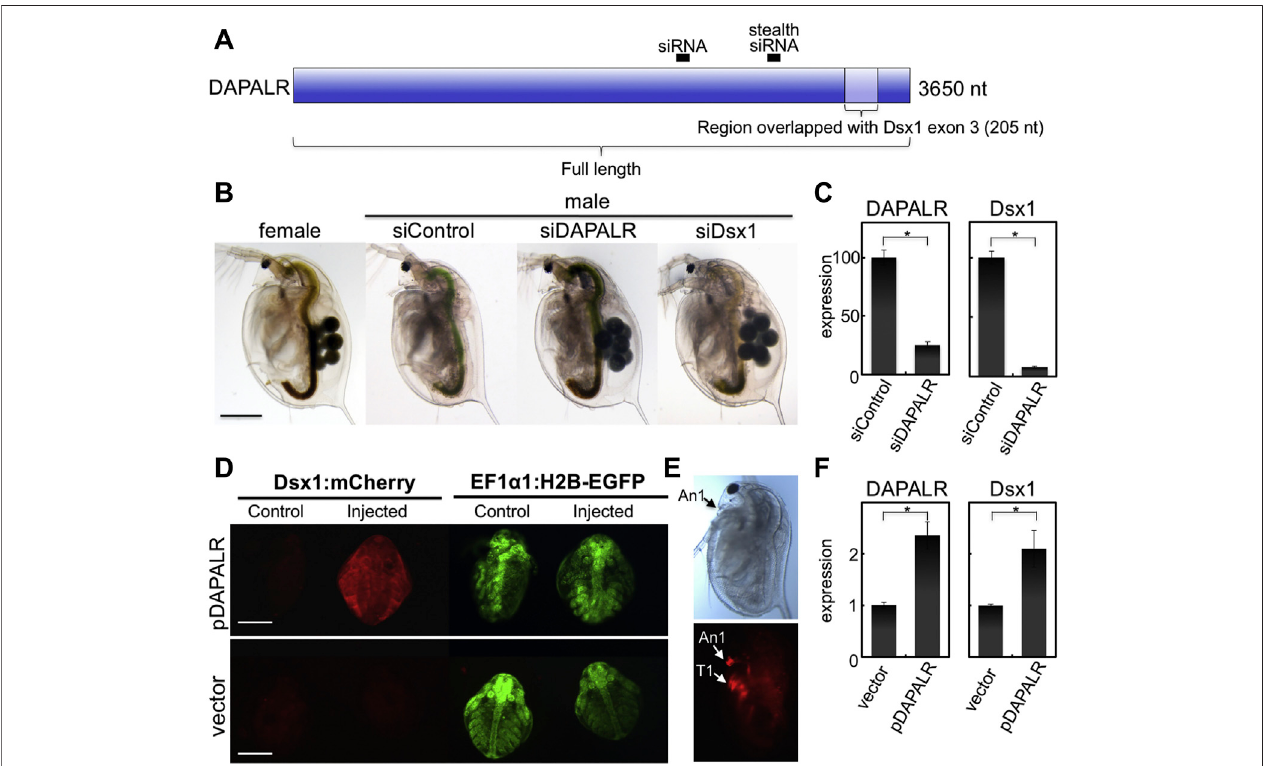
FIGURE12| Knockdown andoverexpressionof DAPALR . (A) PositionofsmallinterferenceRNAs(siRNAs)and RNAsused forknockdown and overexpression of DAPALR .ThesiRNAsweredesignedinthe DAPALR -speci fi cregion.Thefull-lengthof DAPALR oritsregionoverlappedwith Dsx1 exon3( Dsx1 α -isoformspeci fi cregion) and was ectopically expressed in females. (B) Lateral view of D. magna injected with stealth siRNAs. DAPALR - and Dsx1 -stealth siRNA-injected daphniids produced eggs in their brood chamber located in the dorsal region, in contrast to control-stealth siRNA-injected embryos. Scale bar, 500 μ m. (C) Gene expression pro fi le of DAPALR and Dsx1 in embryos injected with stealth siRNAs of DAPALR (left panel) and Dsx1 (right panel). Error bars indicate the standard error of the mean ( n = 3). p p < 0.05(Student ’ s t test). (D) Ventralviewoffemaleembryosofthe Dsx1 -reporterstraininjectedwith DAPALR -expressionplasmid(pDAPALR)andcontrolplasmid(vector). (E) Lateral view of a female juvenile overexpressing DAPALR . An1, fi rst antennae; T1, thoracic appendage 1. Scale bar, 200 μ m. (F) Gene expression pro fi le of DAPALR and Dsx1 in embryos injected with pDAPALR (left panel) and vector (right panel). Error bars indicate the standard error of the mean ( n = 3). p p < 0.05 (Student ’ s t test). Adapted from Kato et al.